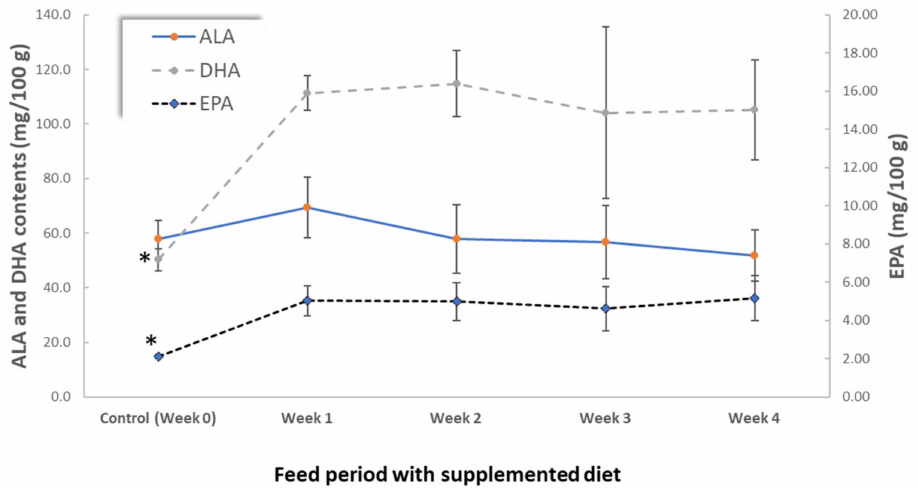
Figure 1. ALA, EPA and DHA contents (mg/100 g) in eggs from hens fed with Nannochloropsis oceanica supplemented diet during the 4 weeks of trial. For the same FA, * means statistically significant differences ( p < 0.05) (N =